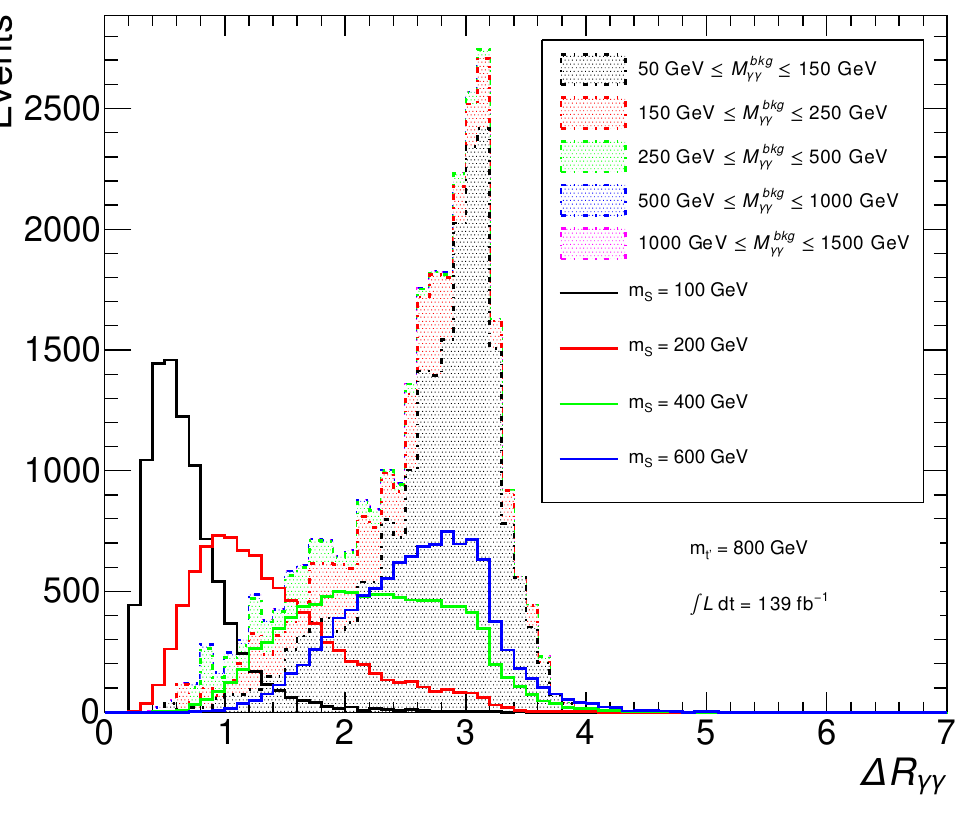
Figure 7 . Distributions of (cid:1) R (cid:13)(cid:13) of the two photons with invariant mass closest to m S , at the reconstructed level, with m t 0 = 800 GeV and various m S values. In the plot, cuts 1 and 2, as de(cid:12)ned in table 2, have been applied.